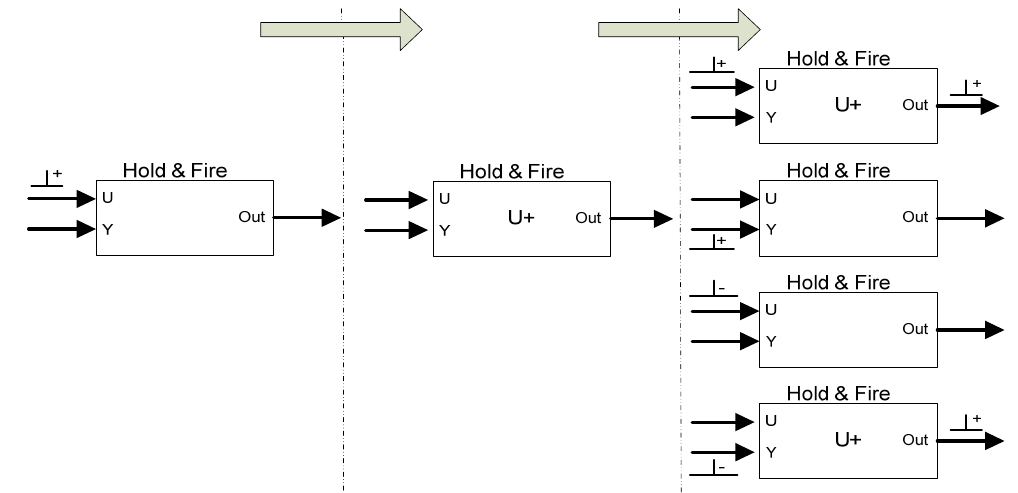
Figure 7. Spikes Hold&Fire evolution form a positive U